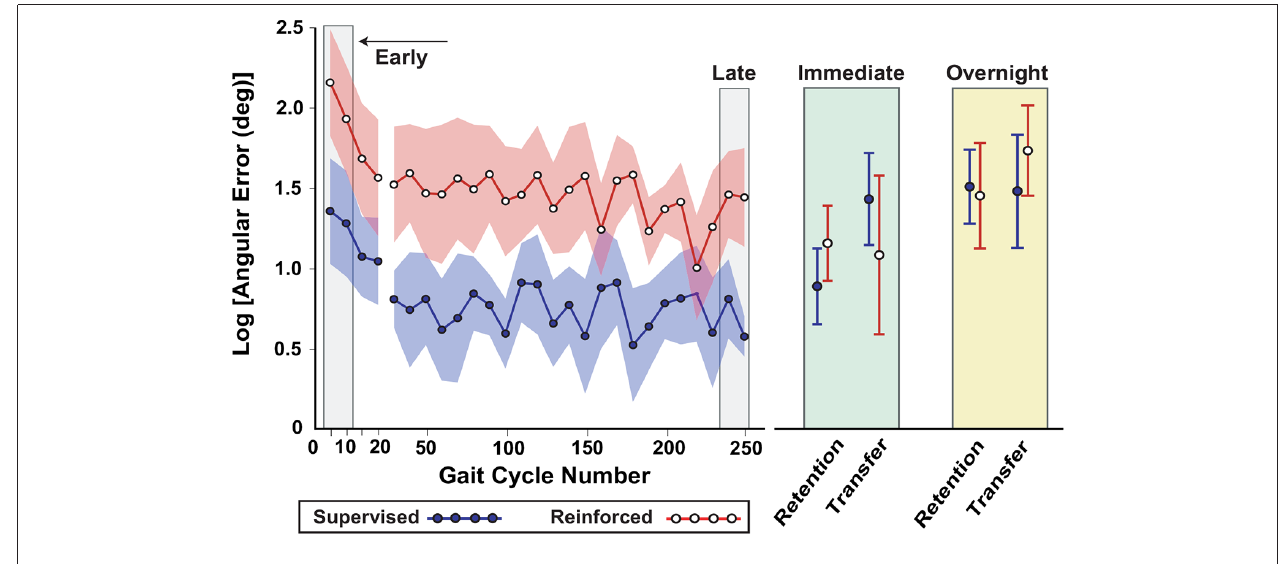
sample size and high within- and between-subject variability, only a descriptive analysis of this data was performed. At the start of practice the averages are shown for 5-trial bins, while the rest of practice (through late practice) shows 10-trial bins. Shading and error bars indicate the standard